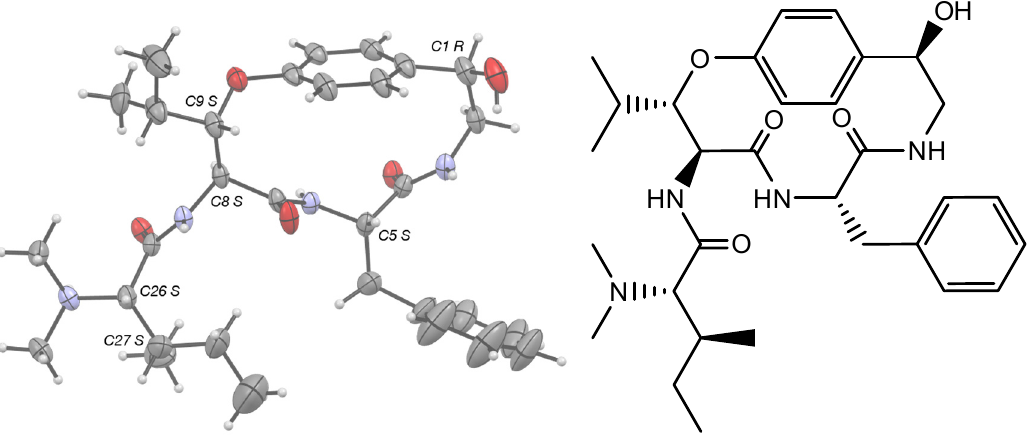
Figure 4. Structure and X-ray ORTEP representation of pandamine ( 1 ).